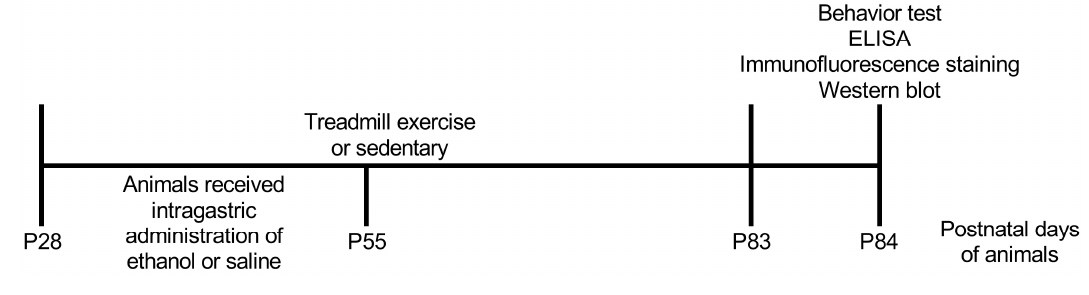
Figure 1. Timeline of the experiment.